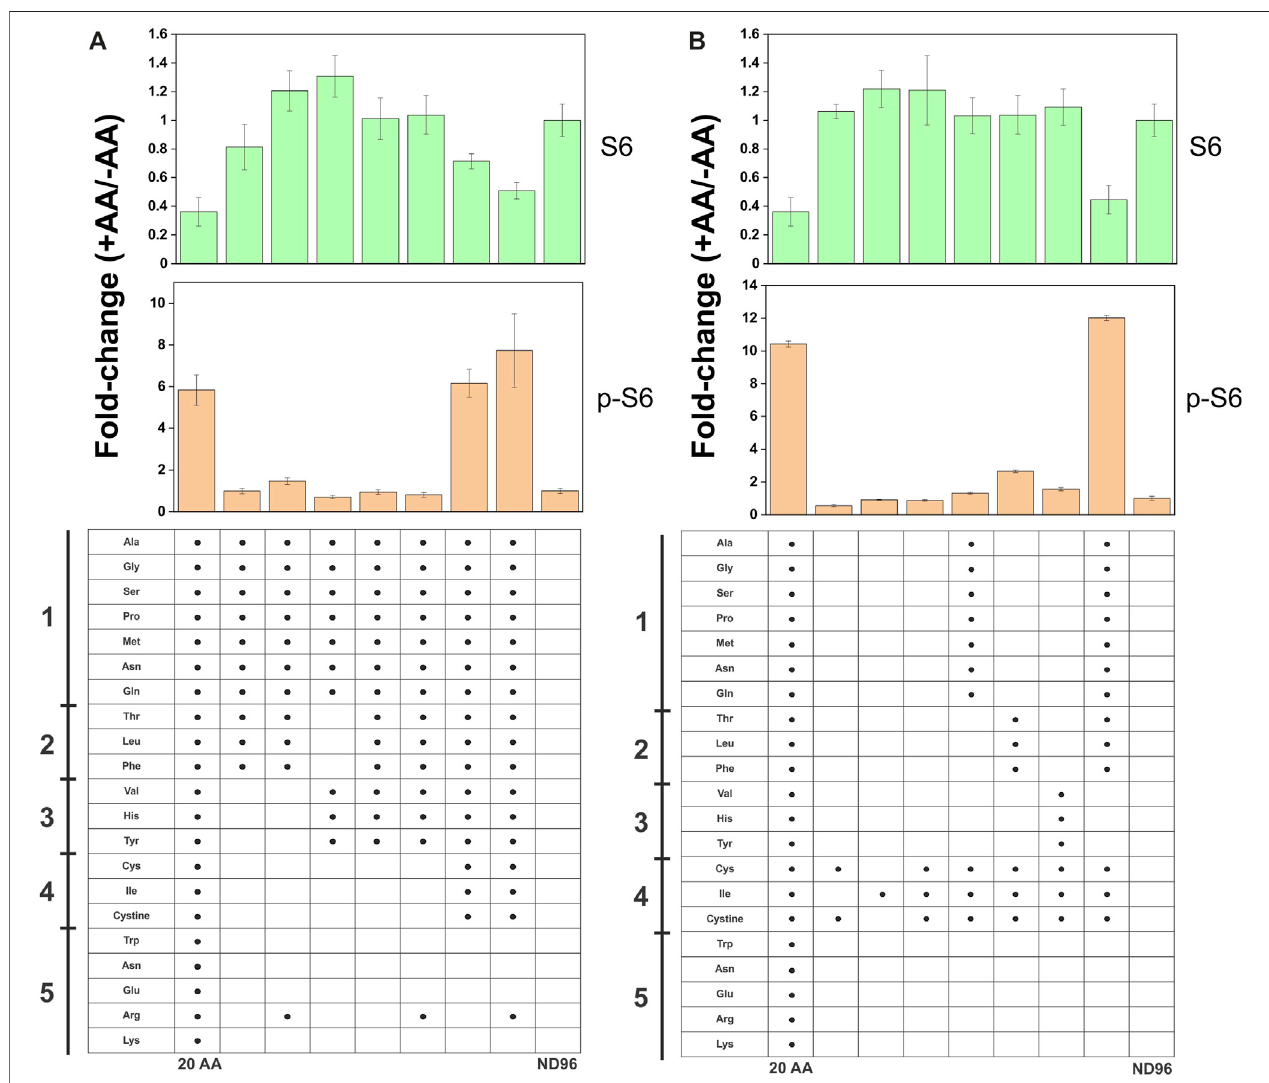
FIGURE 9 | Complex amino acid requirements for full activation of mTORC1 in oocytes. Un-injected oocytes were incubated for 4 days in OR 2+ (pH 7.8) buffer. In theexperiment, oocyteswereincubated withdifferentaminoacidmixtures(1 mMeach)for4 h.Activation ofmTORC1 wasmeasured byimmunodetectionofribosomal protein S6 and phospho-S6. Densitometry in each bar graph was normalized to the negative control, where oocytes were incubated without amino acids in 1 × ND96 buffer only (last column). Bar graphs represent the mean ± S.E.M. of 3 experimental repeats ( e (cid:2) 3) with each condition in each repeat representing the protein expression of12 oocytes ( n (cid:2) 12). The amino acidcomposition ofeach groupshown below thedensitometry bar graphs wasbased on severalcriteria:substrate af fi nity for SNAT2, previously shown ability to activate mTORC1, and amino acids previously shown to activate mTORC1 when injected into oocytes (Christie et al., 2002). Amino acid groups are indicated by numbers 1, 2, 3, 4, 5 in the margin. The graph was divided into panels A and B for clarity.